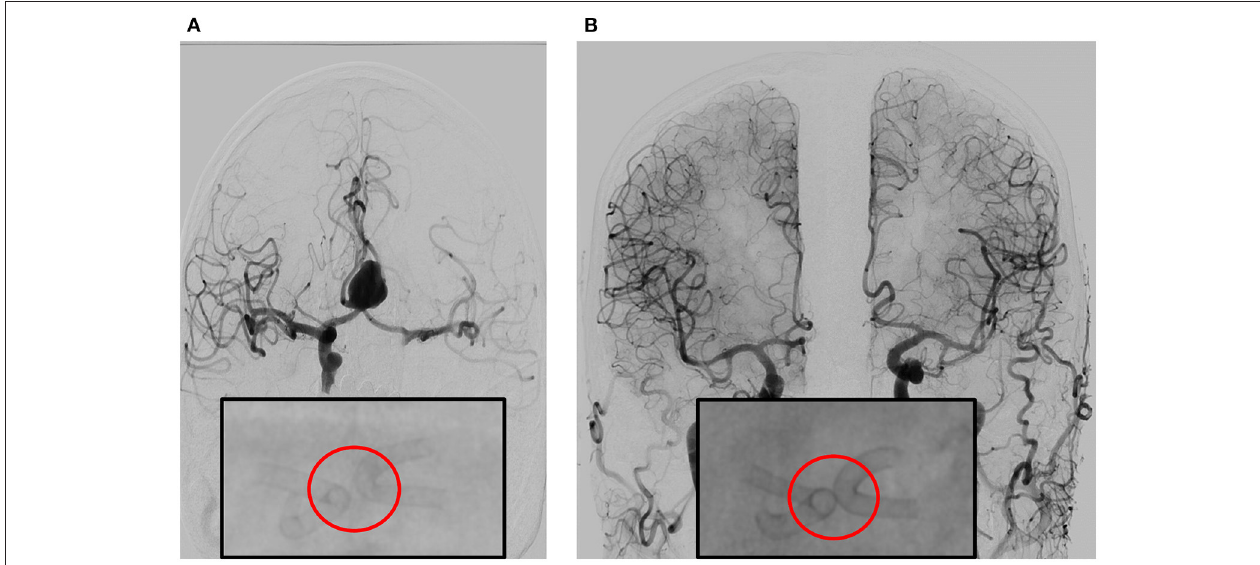
FIGURE 2 | (A) Angiography prior to double stent bilateral deployment. Magnified: Angiography shows regular stent profile after the deployment with very small distance between the stents. Deployed on A1-2 angle of the left and right anterior cerebral artery (ACA). (B) Follow-up angiography at 6 months, obtained by bilateral contrast media (CM) injection from common carotid artery on the right and left side. The image shows complete exclusion of the aneurysm—which is quite rare—with diversion of the blood flux, in complete separation of intracranial flux of the left and right hemisphere. Magnified: Angiography shows regular stent profile with outer profile of the stent curves getting closer and then coming into contact, resulting in the “kissing” effect. Compared to stent positioning in (A) , the image in (B) is an indirect sign of shrinking of the aneurysm